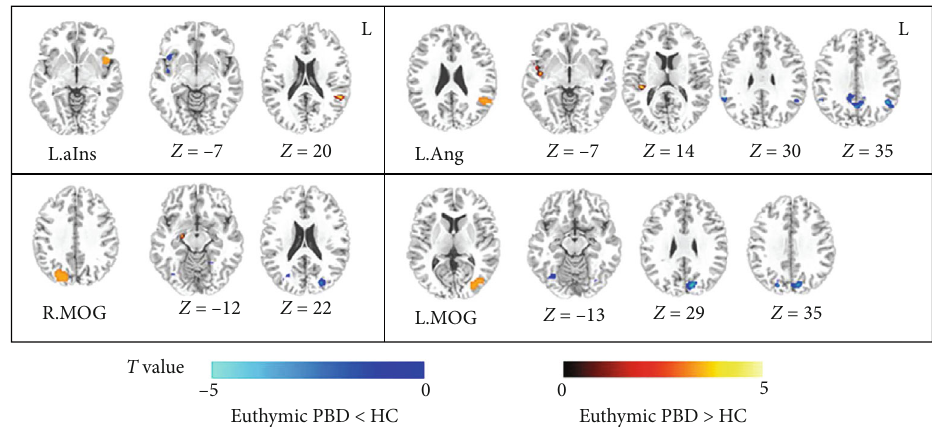
Figure 4: The di ff erence of functional connectivity maps seeded at 4 ROIs between the euthymic pediatric bipolar disorder (PBD) and healthy control (HC) groups ( P < 0 : 005 , cluster size > 621mm 3 ). The left column for each subgraph shows the seed. The hot color represents higher correlation coe ffi cients, and the cold color represents lower correlation coe ffi cients in the euthymic pediatric bipolar disorder (PBD). ROIs ’ abbreviations are consistent with those shown in Table 2. Table 3: The signi fi cantly altered functional connectivity between the euthymic PBD and HC groups in 4 seed maps. MNI coordinate T ROI Regions value Cluster size (mm 3 ) x y z Right insula 42 -12 L.aIns Left temporoparietal junction -48 -45 1080 Right superior temporal cortex 37 -30 Left angular -51 -54 L.Ang Right angular 56 Precuneus Left cuneus -9 -84 L.MOG Right inferior occipital cortex Right hippocampus R.MOG